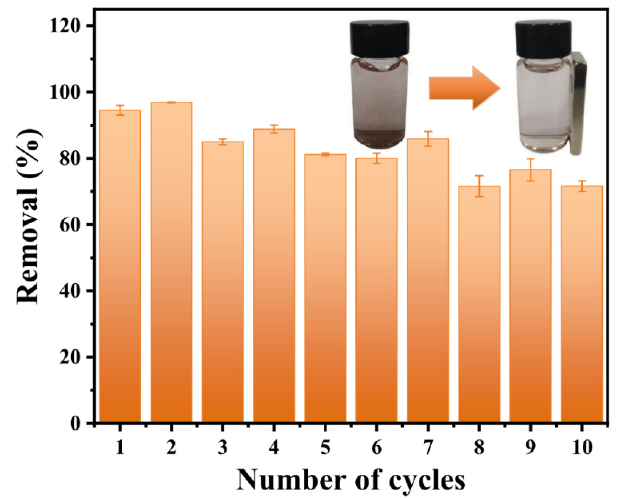
Figure 7. The recycle performance of CeFe-CM-T for phosphate adsorption, and the inset is the display of magnetic separation.